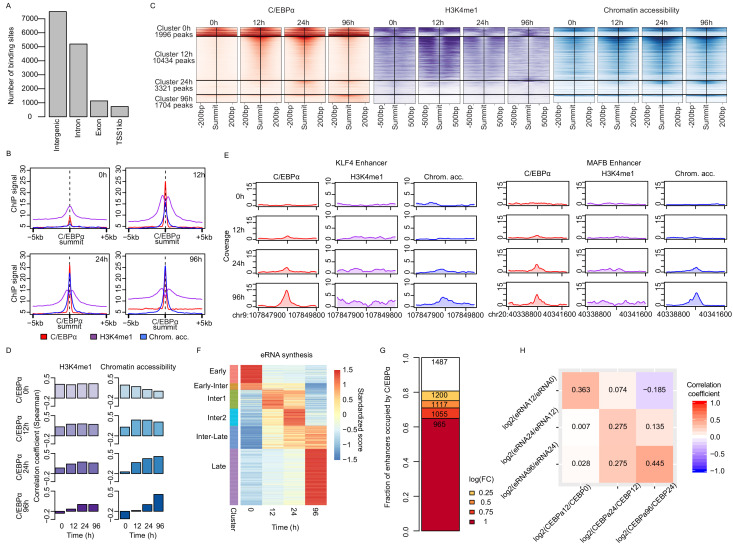
C/EBPα binding induces chromatin opening and activate enhancers.(A) C/EBPα binding location across the genome during transdifferentiation. (B) Average signal of ChIP-seq of C/EBPα (red) and H3K4me1 (purple) or ATAC-seq (blue) on ±5 kb around C/EBPα binding sites where chromatin accessibility is limited at 0 hr (n = 4550). Each panel depicts coverage at the indicated time. (C) Coverage plots of genome-wide data sets as indicated. Rows represent C/EBPα binding sites that appeared at indicated times and were sorted by intensity. The coverage was aligned to the summits of C/EBPα binding sites. (D) Spearman's correlation coefficients between C/EBPα and histone H3K4me1 or chromatin accessibility signal at indicated time points. (E) Exemplary coverage plots for KLF4 and MAFB enhancers show that C/EBPα binding induces chromatin opening. (F) Heatmap of eRNA synthesis changes induced by C/EBPα for six clusters obtained with k-means clustering. (G) Fractions of enhancers where eRNA synthesis was altered upon C/EBPα binding. (H) Spearman's correlation coefficient heatmap of log2 fold changes of eRNA synthesis and C/EBPα binding signal from previous time points.